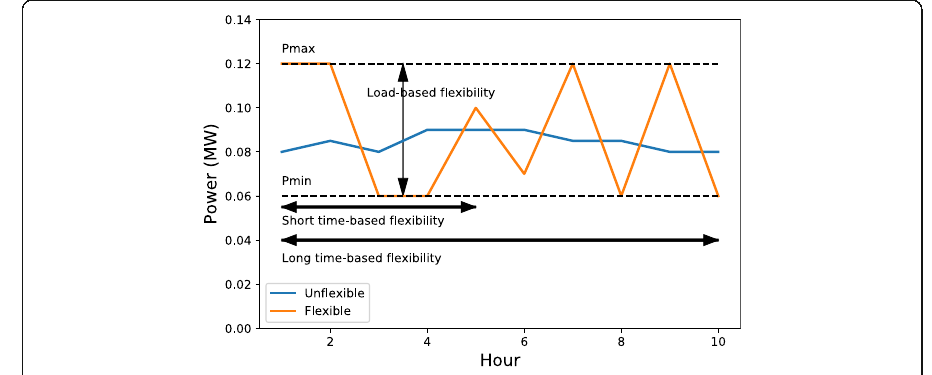
Fig. 1 Schematic of baseload vs flexible process power